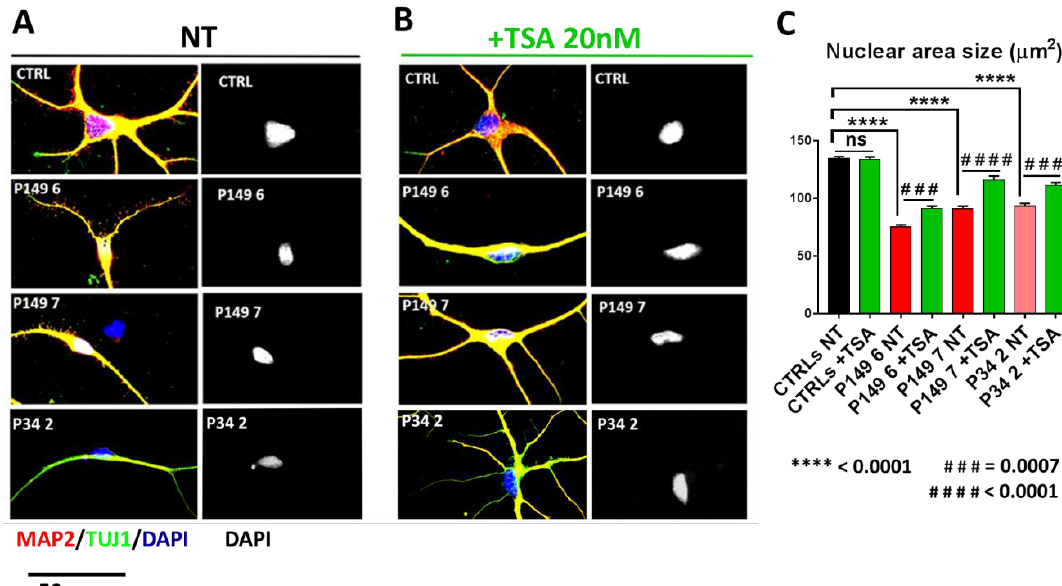
Figure 3. Partial rescue of the reduced nuclear size of 45 days neurons from P149 neural progenitor cell lines 6 and 7 and P34 line 2 by one week treatment with TSA 20 nM. Immunofluorescence of MAP2 (red) and TUJ1 (green) markers in ( A ) untreated (NT) controls and P149 and P34 lines; ( B ) TSA-treated controls and P149 and P34 lines. Nuclei are counterstained with DAPI. Scale Bar 50 µm. ( C ) Nuclei analysis, performed on blue single channel binarized images, using the “ Analyzed Particles” function, scoring at least 50 neurons per sample, shows highly significant decrease in nuclear area size (µm 2 ) in all the CREBBP -mutated cell lines with respect to control lines. Effect of genotype: **** p < 0.0001. All TSA- treated patients’ lines show significant increase in nuclear size as compared to untreated replicas. Effect of TSA treatment on CREBBP +/ − lines: ### p = 0.0007, #### p < 0.0001. No effect on CTRLs (ns = not significant) (Kruskal – Wallis non-parametric test).